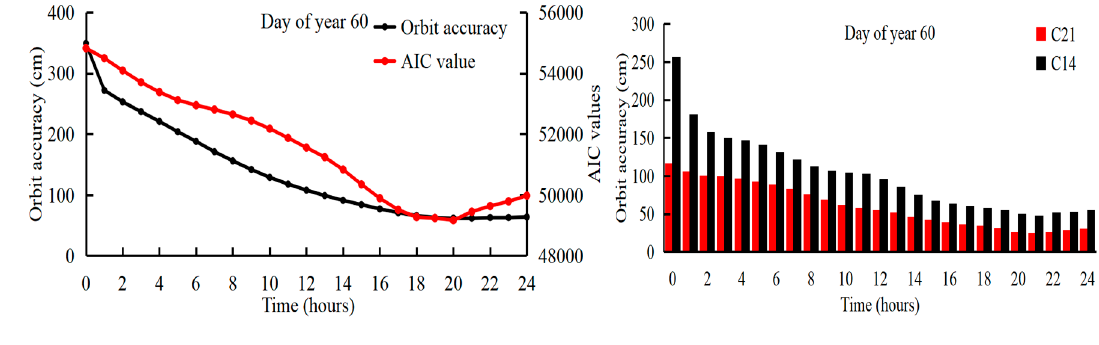
Figure 15. AIC values and the corresponding BDS orbit accuracies on DOY 60.